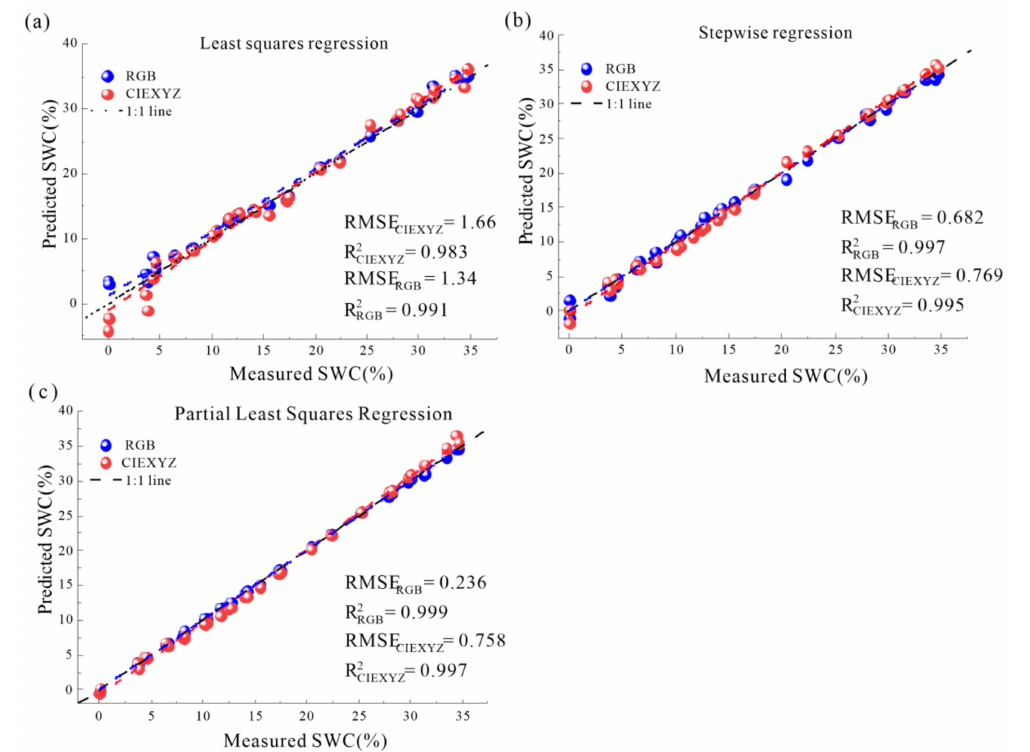
Figure 16. Validation results of different models of SWC prediction: ( a ) the LSR model; ( b ) the STR model; ( c ) the PLSR